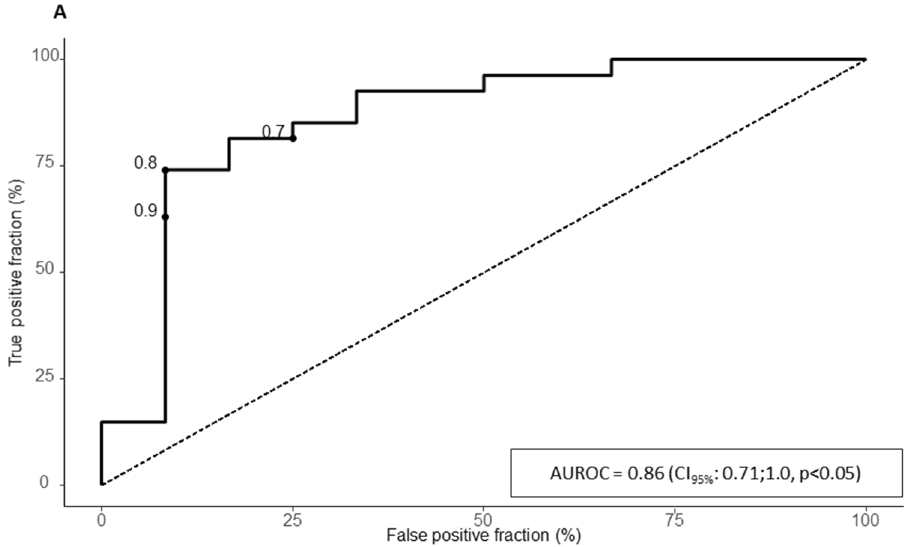
Figure 1. Receiving operator characteristic curve for the ability of dynamic arterial elastance to predict pressure response to a decrease of norepinephrine dose. AUROC area under the ROC curve.